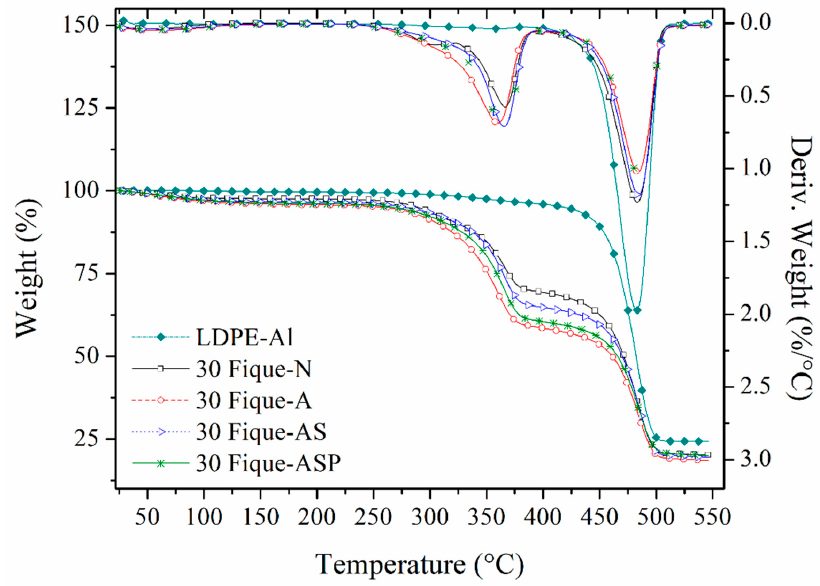
Figure 6. Thermogravimetric Analysis (TGA) thermogram for LDPE-Al and composites with 30% fique fiber with different surface